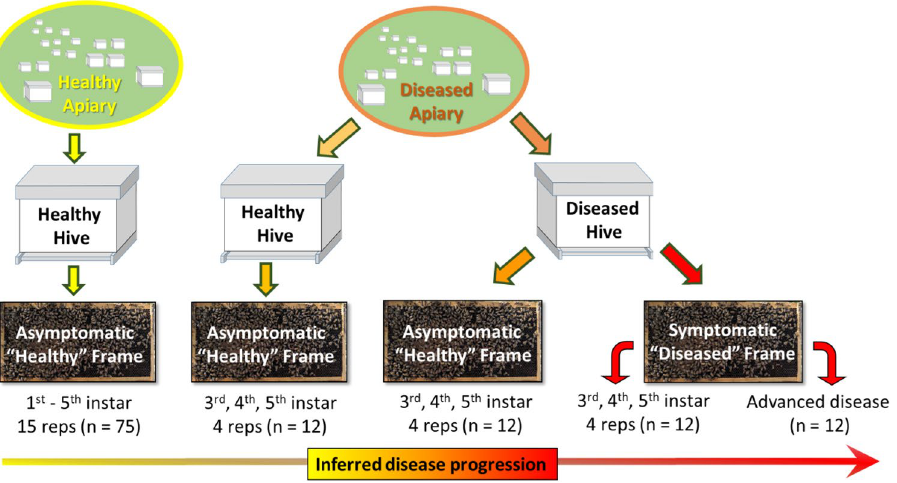
Figure 1. Experimental design and sample size used to infer disease progression. From a disease free “Healthy” apiary in Tucson AZ, we sampled first through fifth instar larvae from three different colonies, five repetitions per colony. From each diseased apiary in Illinois, we sampled one “Healthy” hive with no disease symptoms, and one “Diseased” hive. From the diseased hive, we sampled both asymptomatic and symptomatic larvae. We sampled 3rd, 4th, and 5th instar larvae and also advanced disease wherein larvae instar was